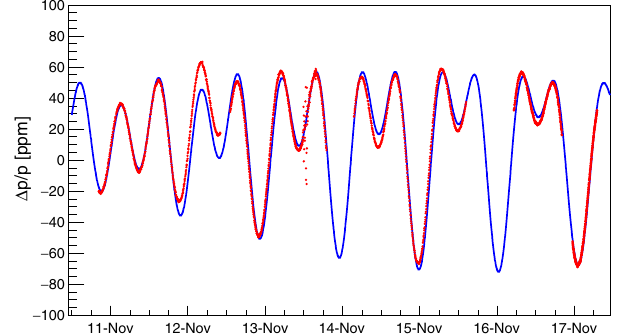
FIG. 6. Predicted (blue line) and observed (red point) tidal energy variations of the LHC ring in November 2016 during long consecutive fills at 4 TeV = c spanning almost an entire week. The outliers that can be observed around midday November 13th are radial oscillations of the ring induced by the surface waves from a magnitude 7.8 Earthquake in